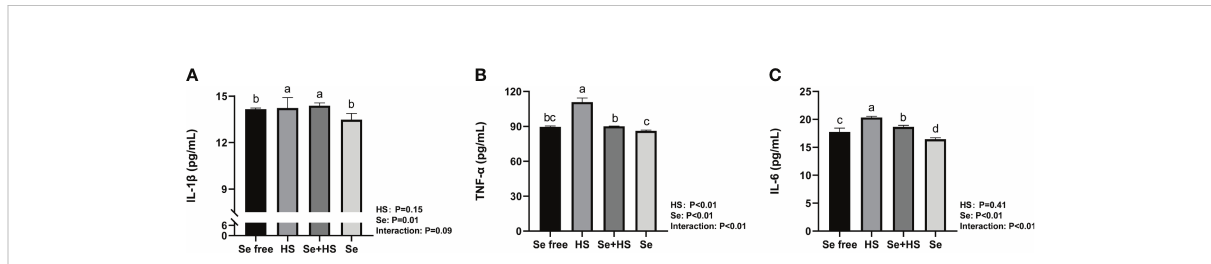
FIGURE 9 Effects of HMSeBA on the concentration of in fl ammatory cytokines in mammary gland of mice under HS (n = 12). The interleukin (IL)-1 b (A) , tumor necrosis factor (TNF)-a (B) , and IL-6 (C) expression levels were measured with an enzyme-linked immunosorbent assay. a-d Different lowercase letters indicate extremely signi fi cant differences between two groups (P < 0.01), while the same lowercase letters indicate no signi fi cant difference between two groups ( P > 0.01).